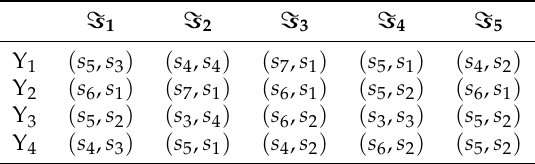
Table 4. Decision matrix Q 4 by Z 4